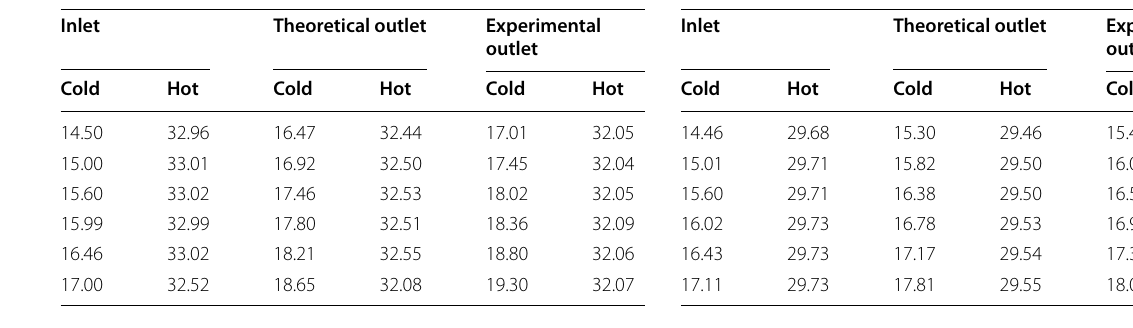
Table 4 Inlet and outlet temperatures (°C)